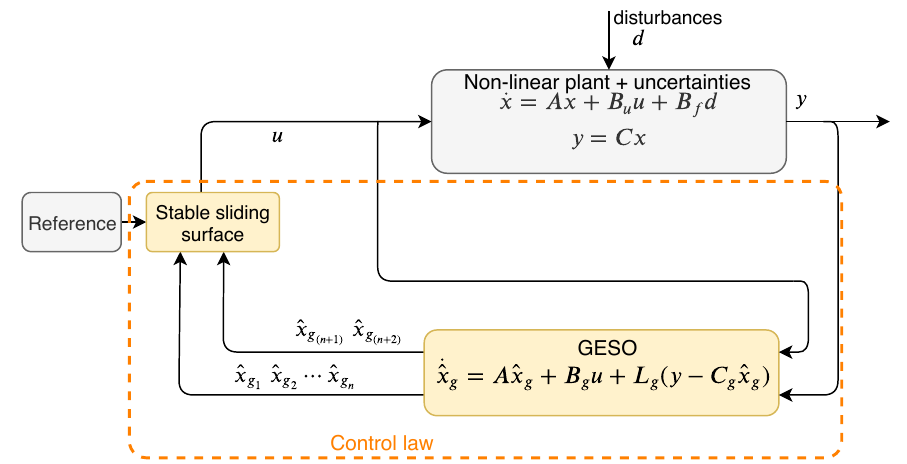
Figure 1. Block diagram of the proposed control